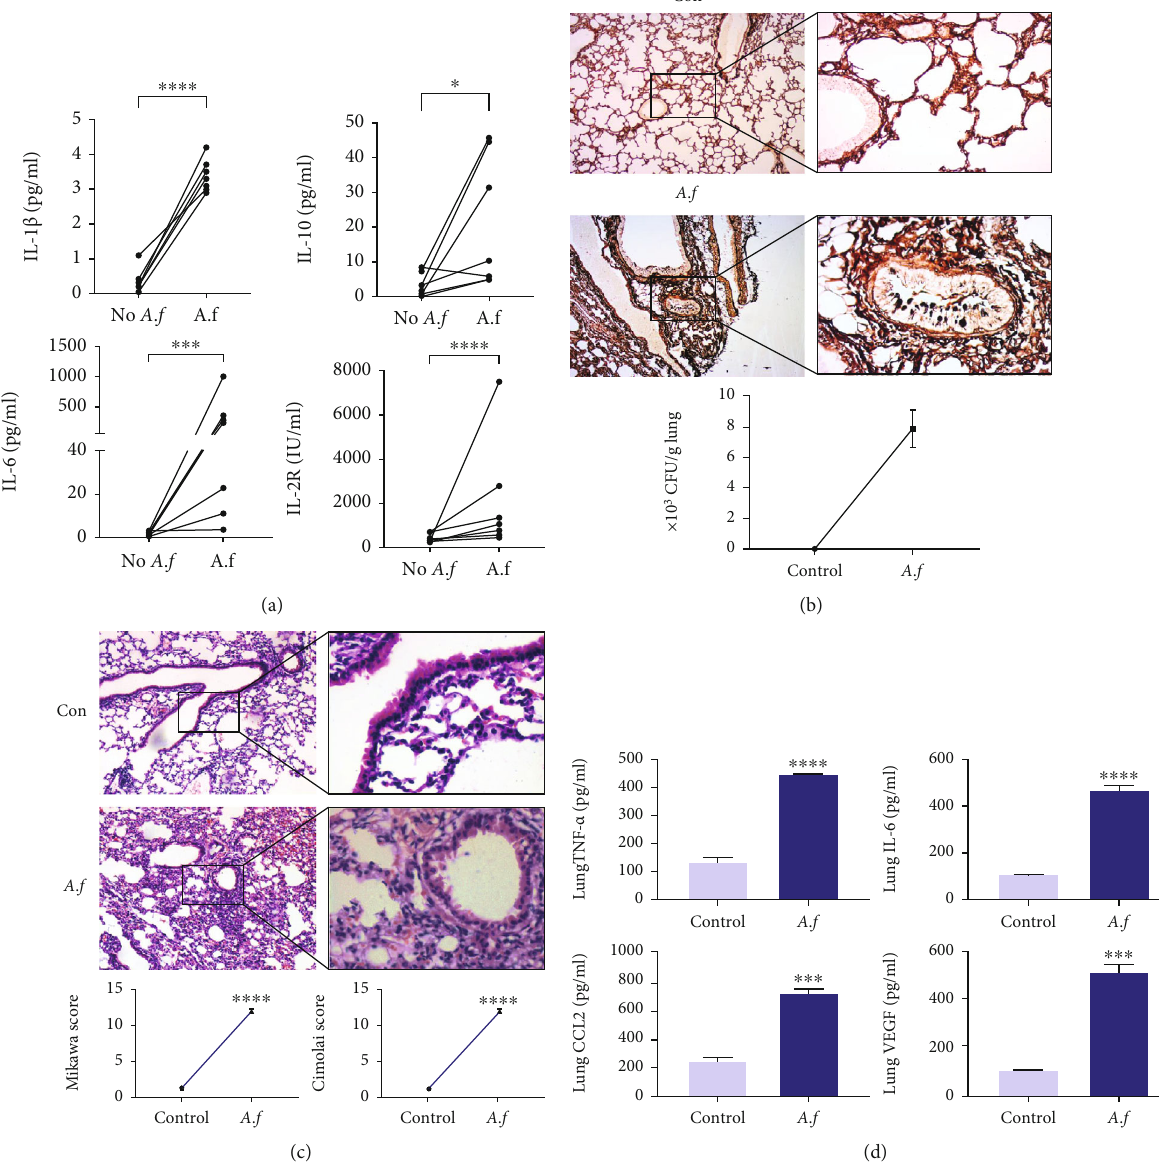
Figure 1: Aspergillus fumigatus infection caused the pulmonary in fl ammatory response. (a) IL-1 β , IL-6, IL-10, and IL-2R are elevated in the serum of patients infected with A. fumigatus ( n = 7 ). (b) C57BL/6 mice were administered intratracheally at a concentration of 50 μ l of 1 × 10 7 viable spores and monitored for 3 days ( n = 5 /group). Grocott ’ s methenamine silver (GMS) and lung colony-forming units (CFUs) ( n = 5 /group). (c) H&E staining of the lung tissues of A. fumigatus -infected mice at 100x and 400x magni fi cation, compared with the noninfected control, alveolar hemorrhage, and in fl ammatory cell in fi ltration were more after A. fumigatus challenge. (d) TNF- α , IL-6, CCL2, and VEGF expression levels in lung tissues of mice were detected by ELISA. A. fumigatus upregulated the production of proin fl ammatory cytokines/chemokines in lung tissues, including TNF- α , IL-6, CCL2, and VEGF ( n = 3 /group). Experiments were done at least three times. ns: not signi fi cant; ∗ p < 0 : 05 , ∗∗ p < 0 : 01 , ∗∗∗ p < 0 : 001 , and ∗∗∗∗ p < 0 : 0001 by Student ’ s unpaired two-tailed t test. Error bars represent